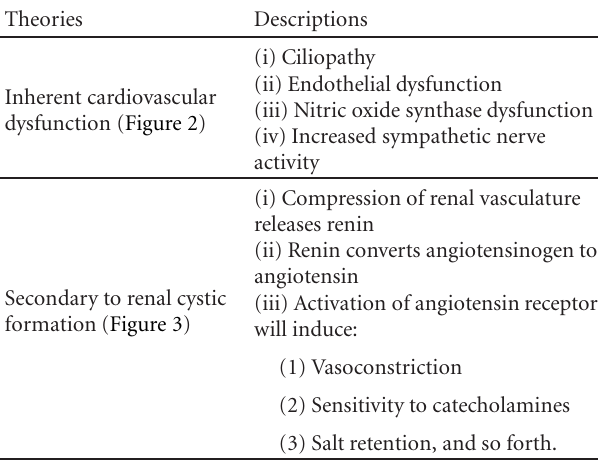
Table 3: Pathogenesis of hypertension in PKD.